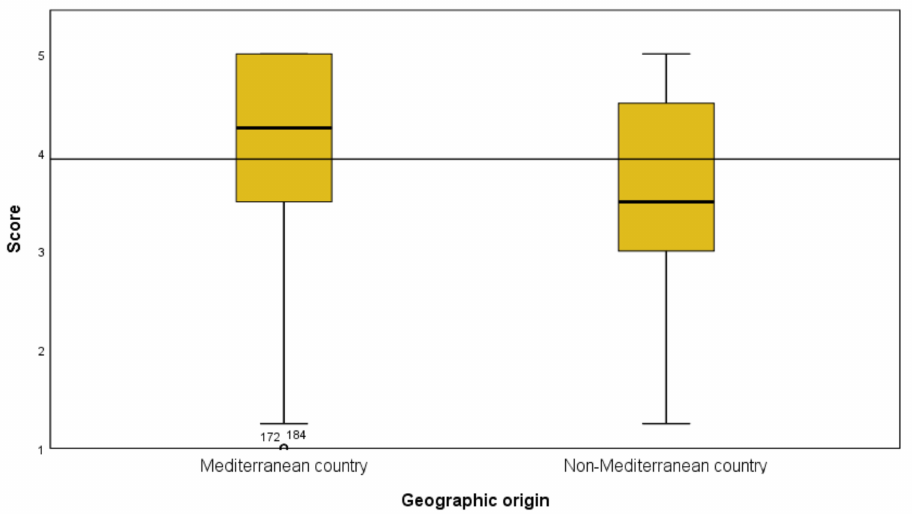
Figure 5. Frequency with which guests engage in water-saving practices by geographic origin on a scale of 1 (never) to 5